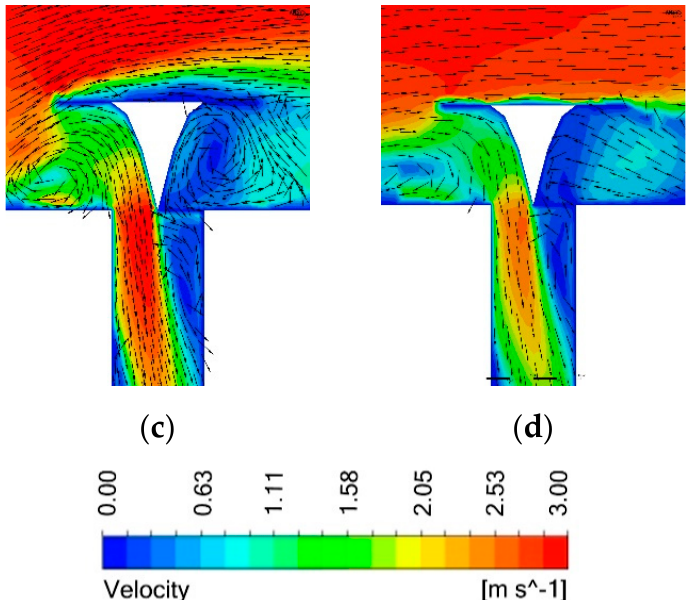
Figure 16. Representation of flow fields around the wind catcher shape variations by velocity color maps and normalized tangentially projected vector fields on the vertical section: ‘empty’ + modified deflector—( a ) cross and ( b ) longitudinal; ‘parabola + modified deflector’ ( c ) cross and ( d ) longitudi- nal direction.